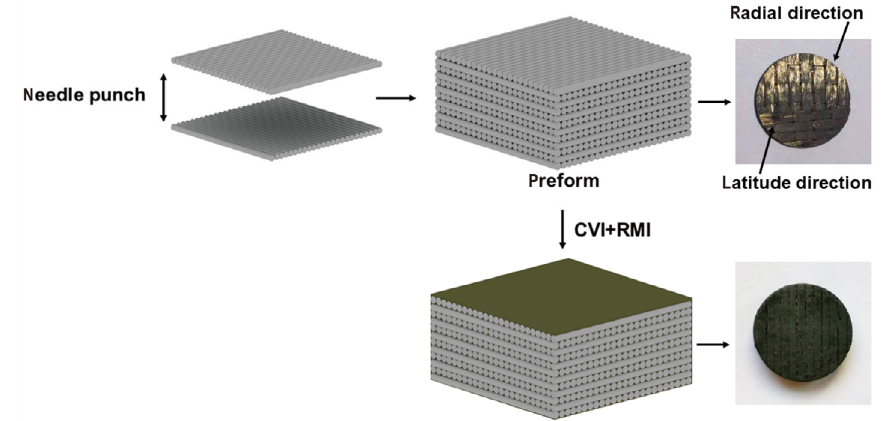
Fig. 1 Schematic diagram showing the pitch-based carbon fiber sheet, fiber preform, and